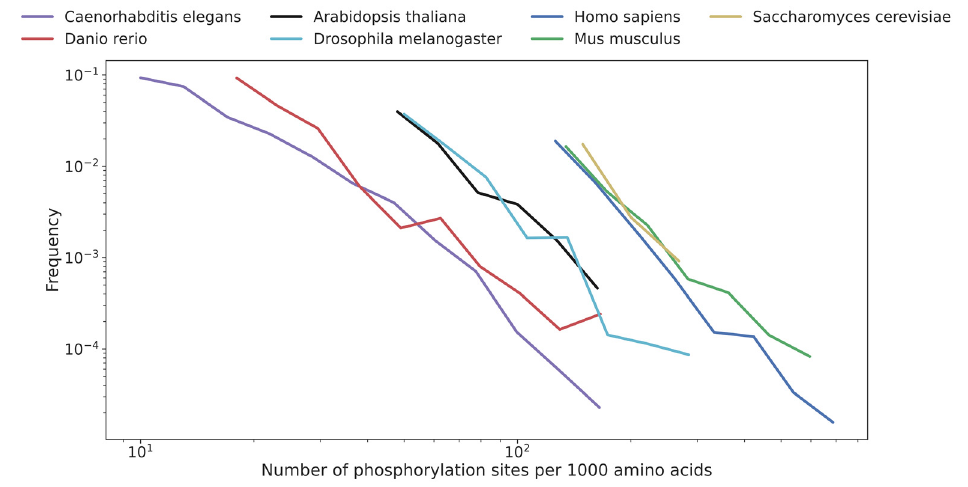
Figure 1. A log–log plot illustrating the relationship between the number of phosphorylation sites per 1000 amino acids and its frequency for seven species. The figure shows a clustering of species into three groups that share similar phosphorylation rates and have a very close distribution of phosphorylation sites. Table 1. Statistics about the proteins of the seven studied